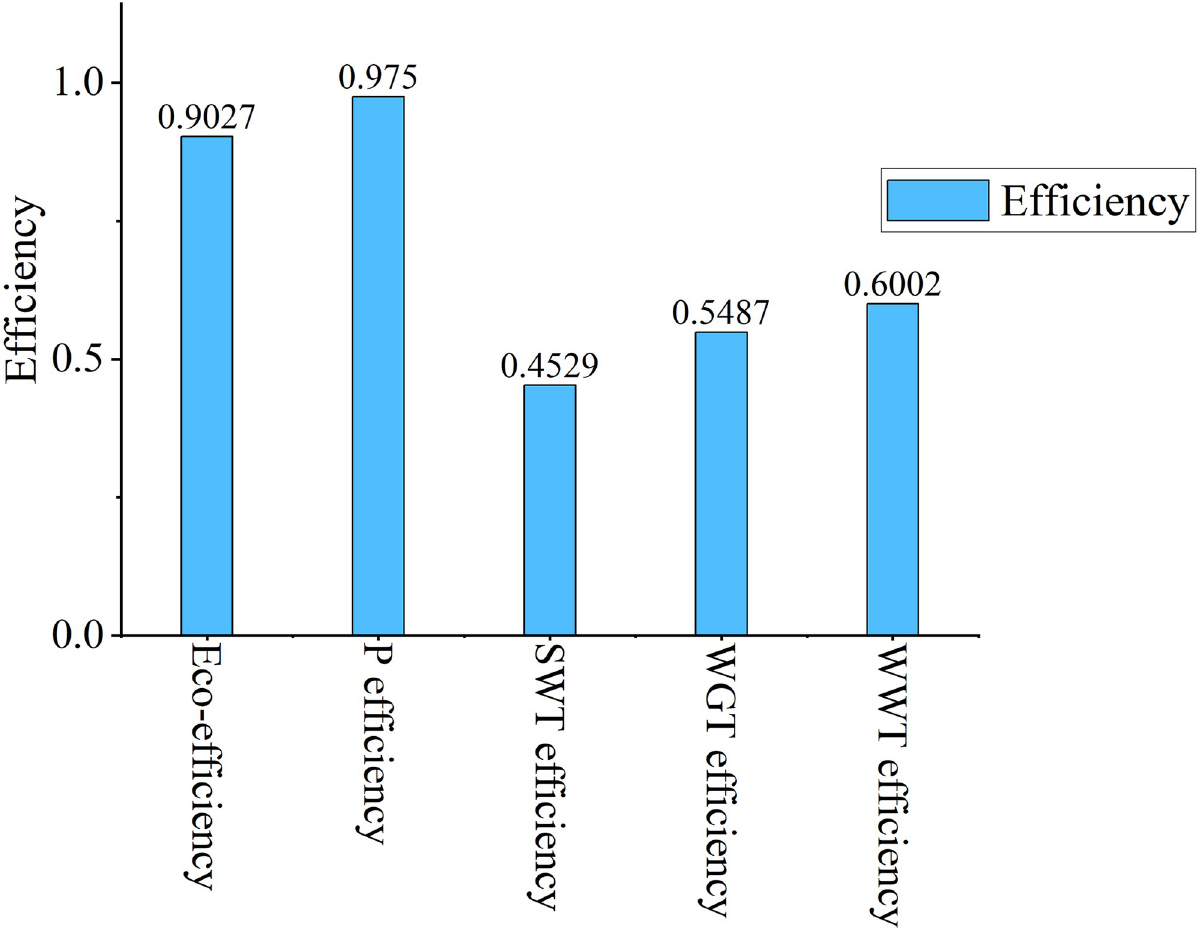
Fig 3. Average efficiency of provincial industrial system.